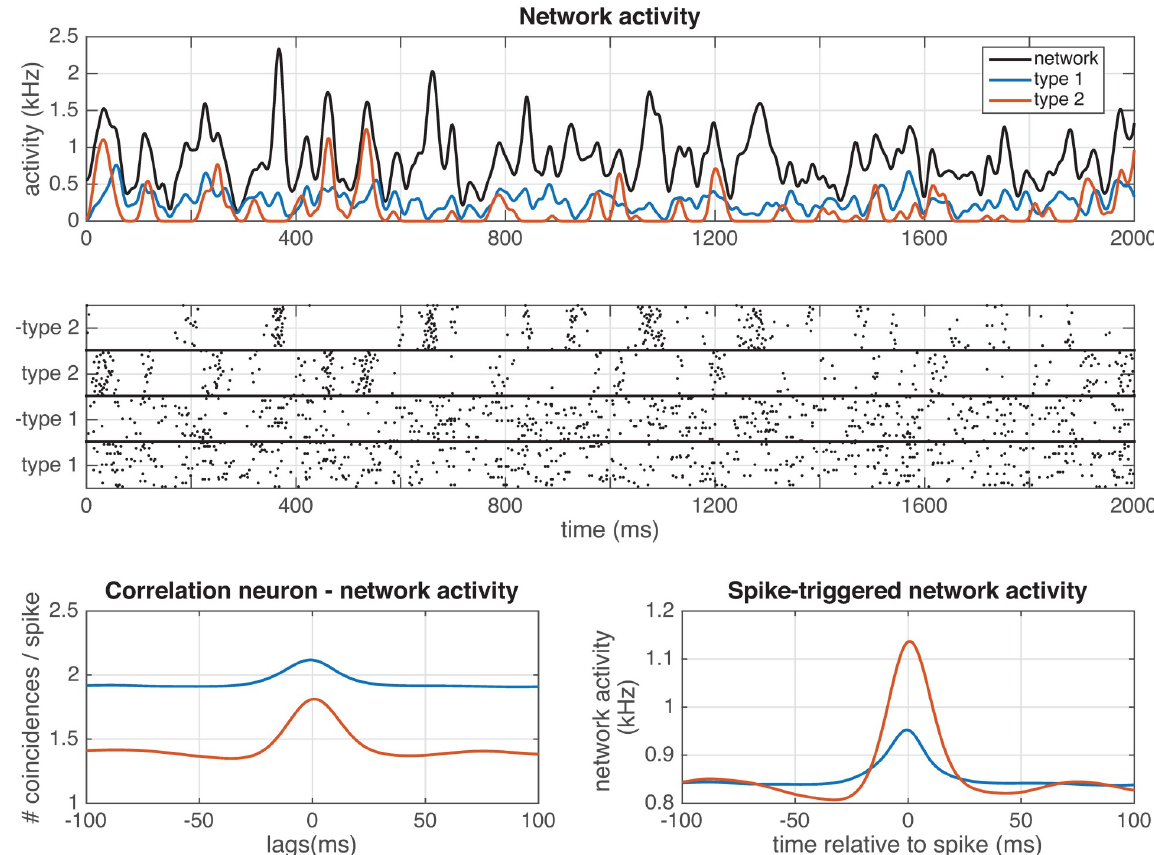
Fig 7. Network activity in a ‘type 1 & type 2’ network. (see section Analysis and Fig 3). A) Average activity of the whole network (black), ‘type 1 on cells’ (blue line) and ‘type 2 on cells’ (red line). B) Spike response of the network. C) Average cross-correllogram between the network activity and ‘type 1, on’ cells (blue line) or ‘type 2, on’ cells (red line). D) Spike-triggered network activity for ‘type 1, on’ cells (blue line) or ‘type 2, on’ cells (red line). Next to the stimulus, each neuron in the network was presented with a noise input (of which half the power was independent, and half was shared with a subset of other neurons). Network: Δ = 7, 5 ms, ν = μ = 1, 5, N = 100. Stimulus: τ = 15 ms, amplitude = 2.7. Noise: τ = 15 ms, amplitude independent noise = 0.5, amplitude shared noise = 0.5. For the network activity, each spike was convolved with a Gaussian kernel ( σ = 6